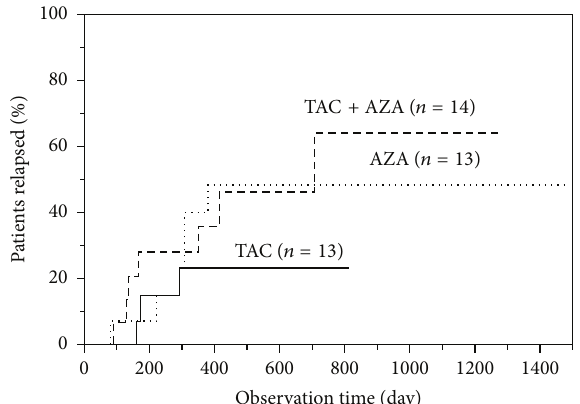
Figure 3: Cumulative relapse rate following remission induced by tacrolimus (TAC) followed by maintenance therapy with tacrolimus alone, azathioprine (AZA) alone, or tacrolimus plus AZA, in patients with ulcerative